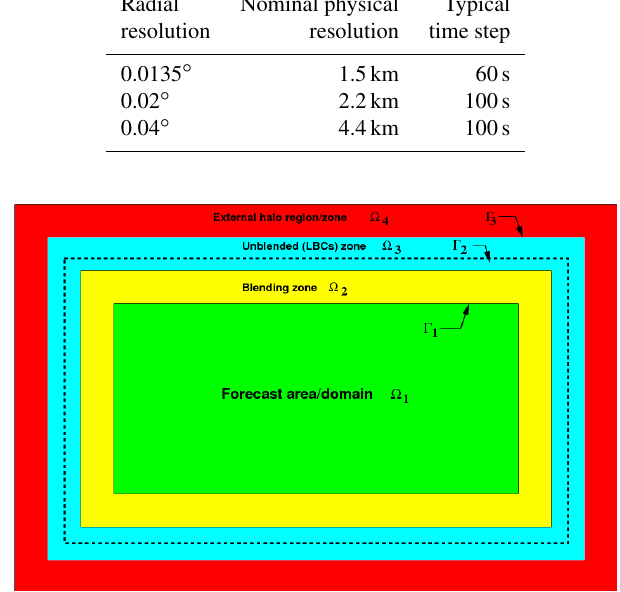
Figure 1. Schematic of the LAM configuration. In this configura- tion a LAM with a physical (or forecasting) region denoted by (cid:127) 1 is shown in green. On the periphery of the forecasting area there is an extended computational domain ( (cid:127) E = (cid:127) 2 + (cid:127) 3 + (cid:127) 4 ) that in- cludes a blending (yellow) zone (cid:127) 2 , an unblended (blue) zone (cid:127) 3 and an external halo (red) zone (cid:127) 4 (which arise from the parallel domain decomposition). Note that in general the relative sizes of ((cid:127) 2 ,(cid:127) 3 ,(cid:127) 4 ) are a lot smaller than (cid:127) 1 , but they are exaggerated here for clarity. Also, the use of the word RIM refers to the whole size of LBCs, which are all the grid points that lie in the region (cid:127) R = (cid:127) 2 + (cid:127) 3 (yellow and